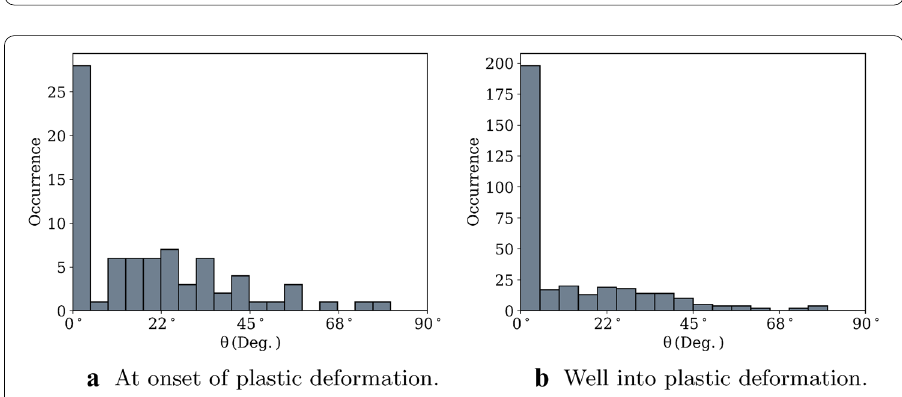
Fig. 8 Location of mobilized planes relative to TATB basal plane within agglomerate ( θ ) (compare with Fig. 4b). Notably, most particles are predicted to yield in-plane with the basal plane, where shear stresses and strains are greatest due to thermal expansion anisotropy of TATB crystals (near θ =